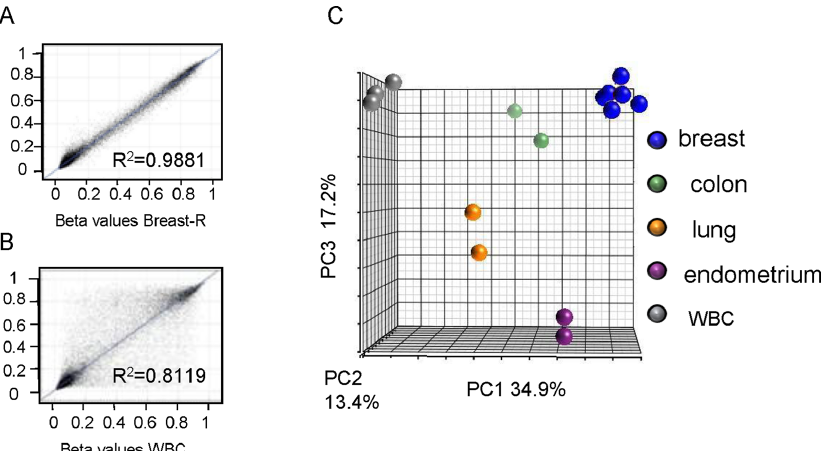
Figure 1. Genome-wide methylation analysis of various normal human epithelial tissues. Pearson correlation coefficient was calculated ( A ) between the right and the left breast and ( B ) between breast epithelium and WBC of the same woman. ( C ) Principal Component Analysis (PCA) grouped 15 tissue samples by their global methylation resemblance into 5 clusters that corresponded with the origin of the tissues.